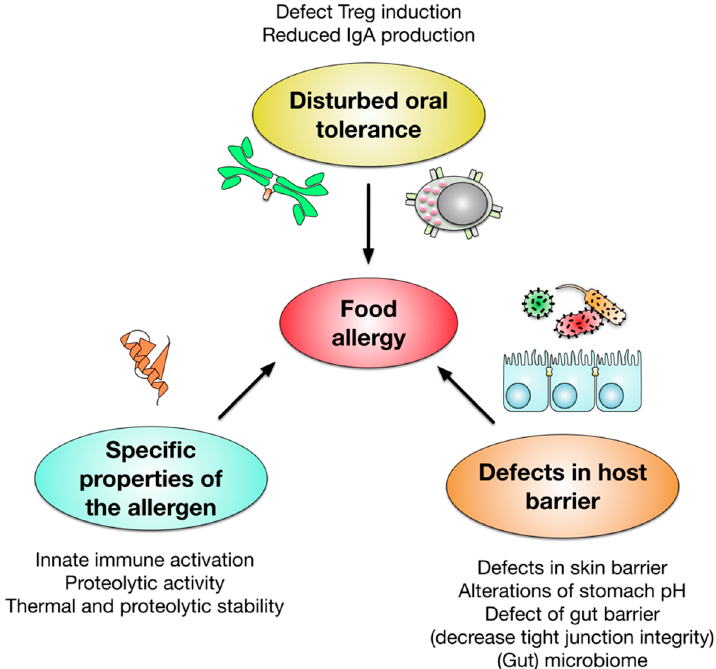
Figure 2. Factors contributing to the development of food allergy. The published literature suggests, that both a disruption of regulatory T cell (Treg)- and immune globulin A (IgA)-mediated oral tolerance and defects in the barrier function of skin and gut contribute to the development of food allergy. Moreover, alterations in stomach pH and the gut and skin microbiome were shown to influence allergic sensitization. In addition, intrinsic properties of the allergen molecules such as innate immune activation, proteolytic activity, or increased thermal and proteolytic stability contribute to allergic sensitization.